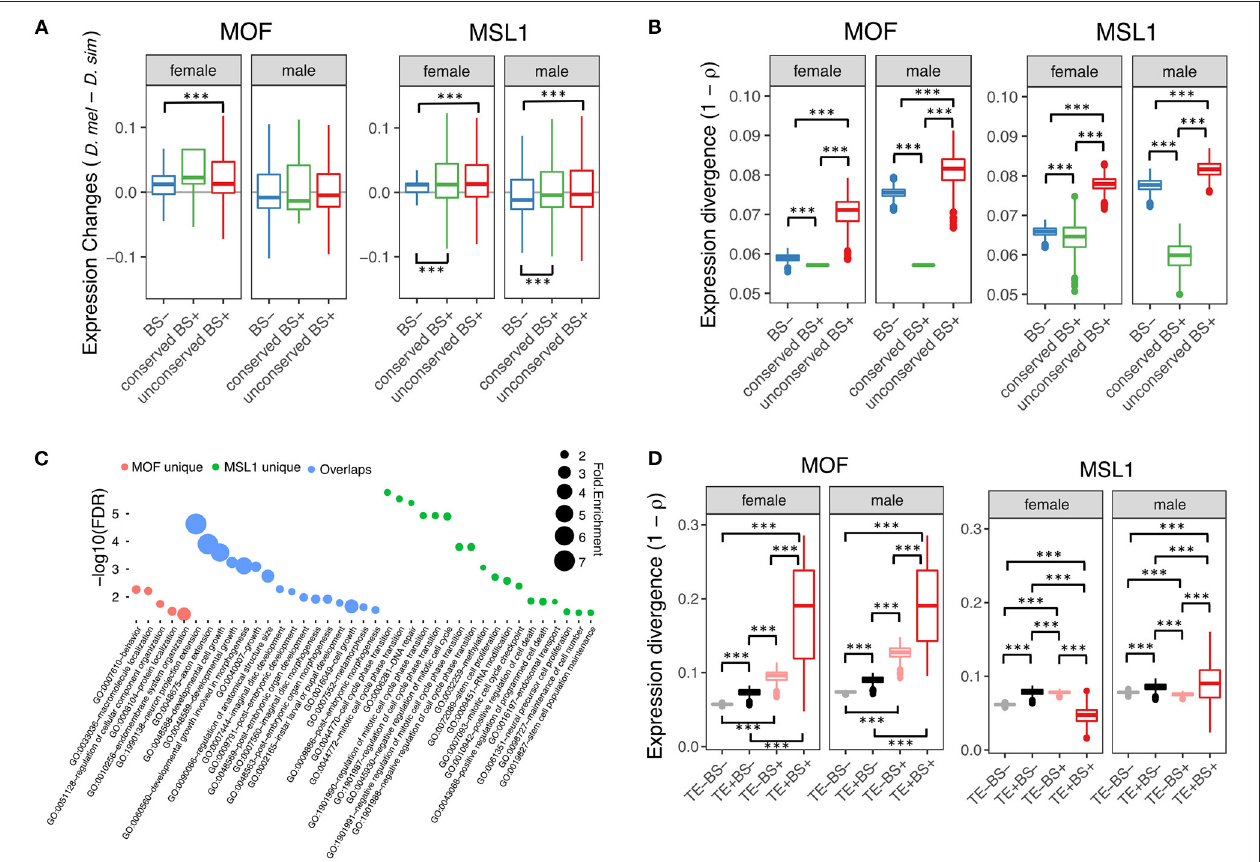
FIGURE 3 | Regulatory role of non-DC sites. (A) Changes in gene expression levels between D. melanogaster and D. simulans in according to presence or absence of non-DC sites. Genes were grouped by presence or absence of non-DC sites 2kb upstream or in gene bodies of D. melanogaster . Expression levels were measured as Transcripts Per Million (TPM) and normalized to a standard normal distribution before between-species comparisons. BS–, without non-DC sites; conserved BS + , with conserved non-DC sites; unconserved BS + , with novel non-DC sites. (B) Non-DC sites are associated with increased expression divergence of nearby genes. Gene expression divergence estimated by Spearman’s correlation coefficients (1 – ρ ) between D. melanogaster and D. simulans . Genes were grouped as in (A) . (C) Gene Ontology (GO) analyses of genes with novel non-DC sites. Only significantly enriched GO terms of “biological processes” are shown. MOF unique: genes only harboring MOF non-DC sites; overlaps: genes harboring both MOF/MSL1 non-DC sites; MSL1 unique: genes only harboring MSL1 non-DC sites. (D) TE-derived non-DC sites contribute to expression divergence of nearby genes between D. melanogaster and D. simulans . Expression divergence was calculated as in (B) and genes were grouped according to the presence of TE insertions or MOF/MSL1 binding sites close to genes as defined in (A) . Significance was determined by the Mann-Whitney U -test: *** P <